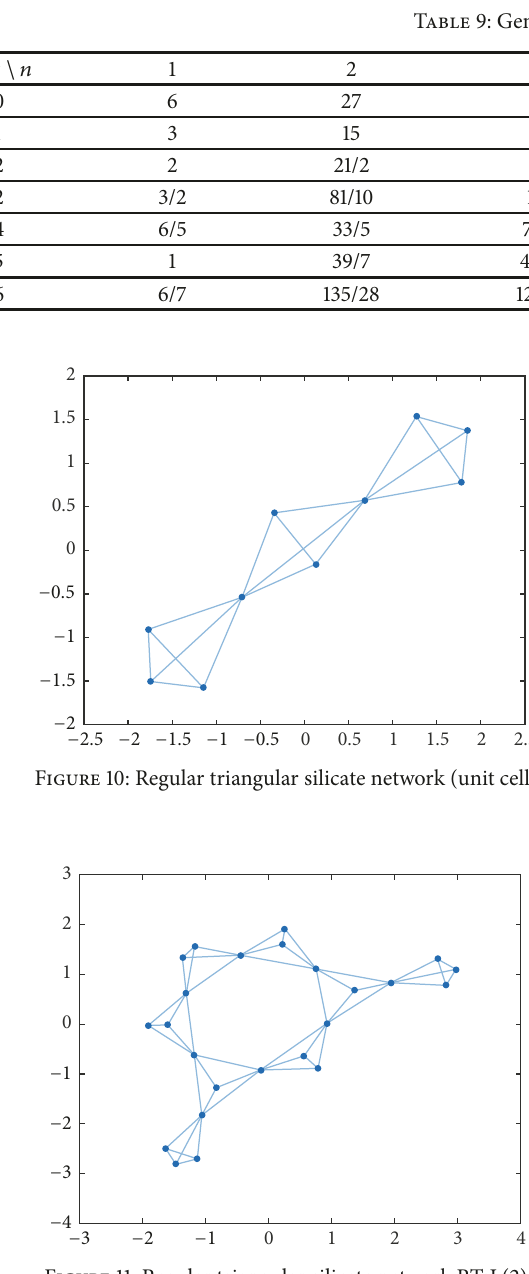
Figure 11: Regular triangular silicate network RTsL(2).